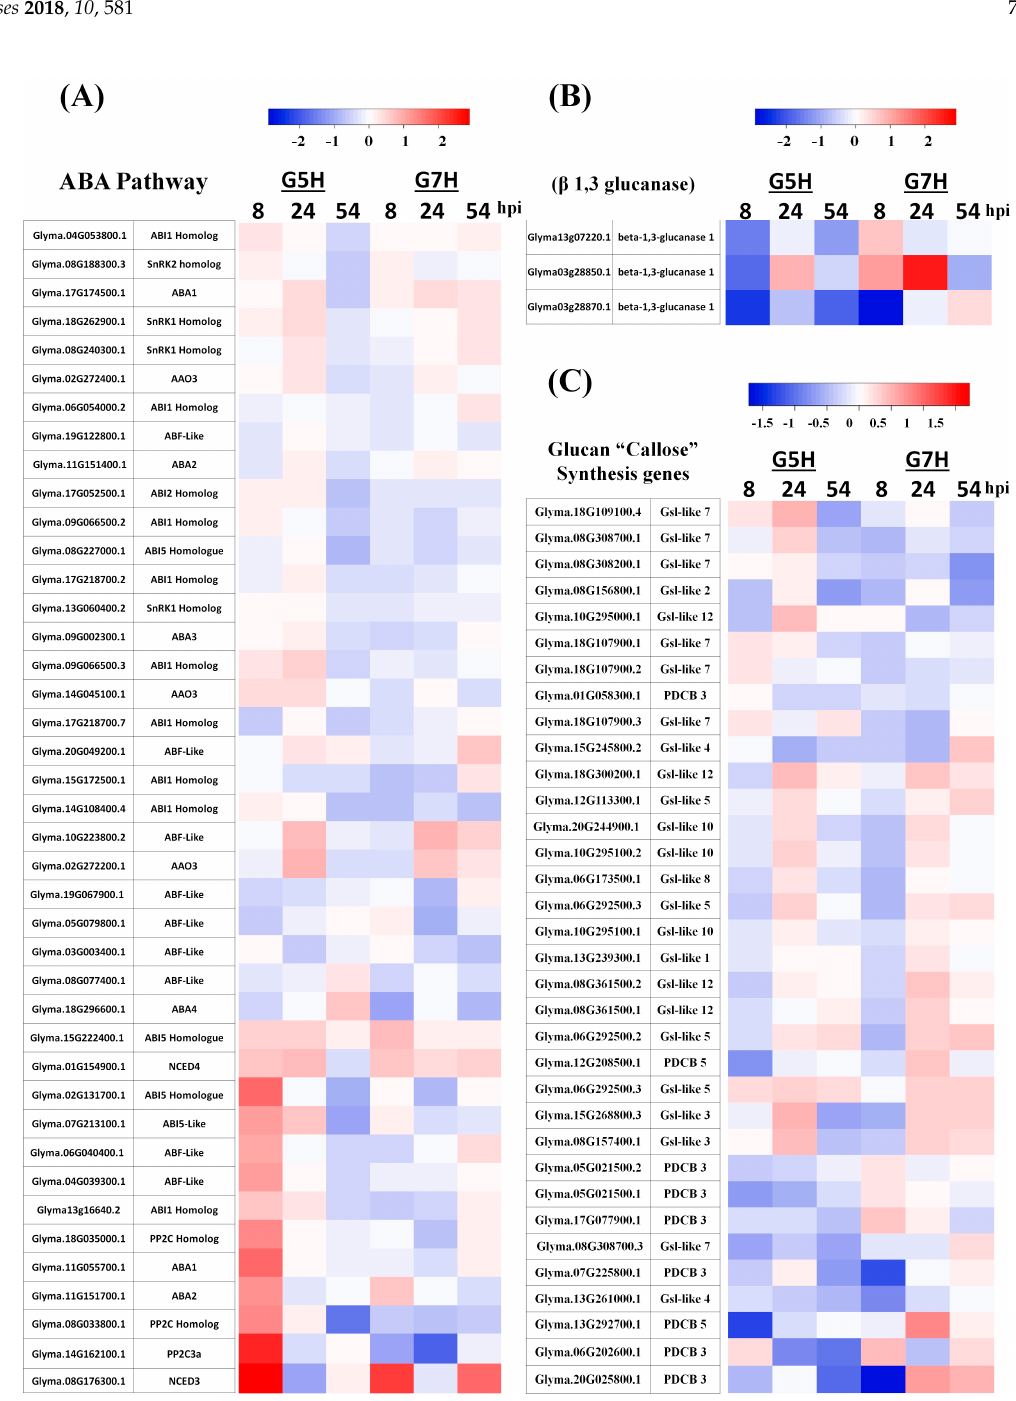
Figure 3. Heatmaps of genes involved in the ABA pathway, synthesis of β -1,3 glucanases and glucan in soybean plants (L29 Rsv3 -cultivar) infected with SMV-G5H and SMV-G7H. Gene expressions from soybean plants infected with the avirulent SMV strain G5H and the virulent strain G7H at 8, 24, and 54 hpi were used to generate heatmaps for genes involved in the ABA pathway ( A ), genes that encode for β -1,3 glucanases ( B ), and glucan synthesis and plasmodesmata callose-binding proteins ( PCBPs ) ( C ). Red and blue indicate up- and down-regulation, respectively, in terms of the fold-change indicated by the scale above each heatmap.